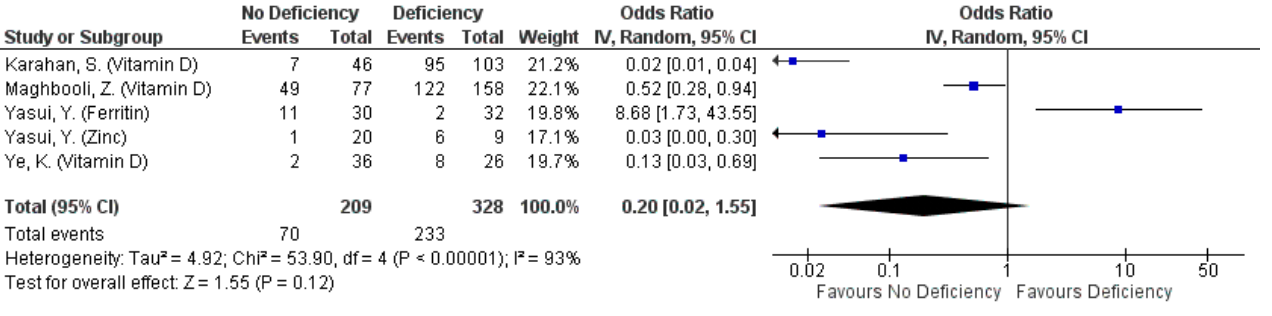
Figure 7. Pooled odds ratio on clinical deterioration of COVID-19 patients (defined by severe/critical clinical condition or